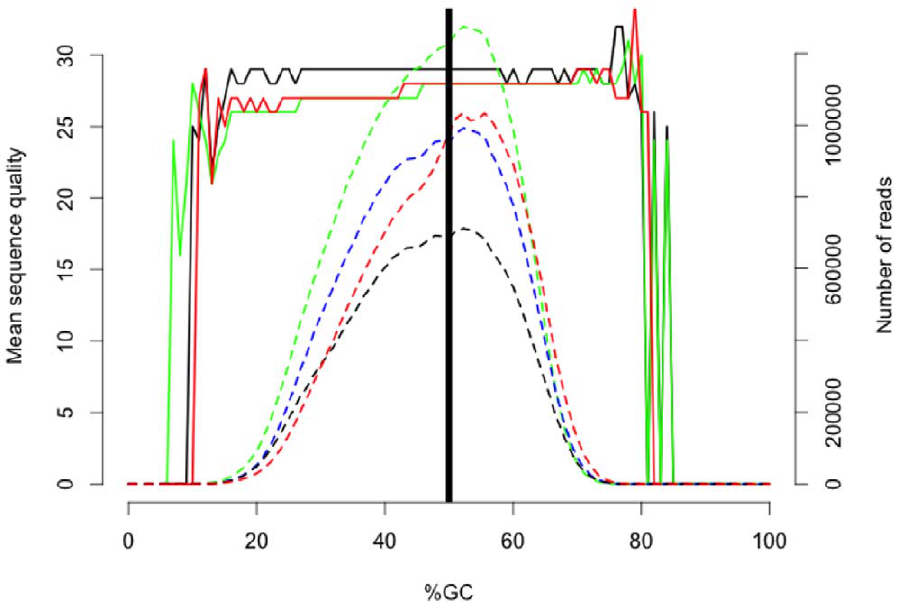
Figure 2. The relationship between %GC content and mean sequence quality (solid lines), as well as the distribution of mean %GC content for the entire 150 bp sequencing read (dashed lines). Each color represents a distinct randomly selected individual library. The colors are consistent between this figure and Figure 1.